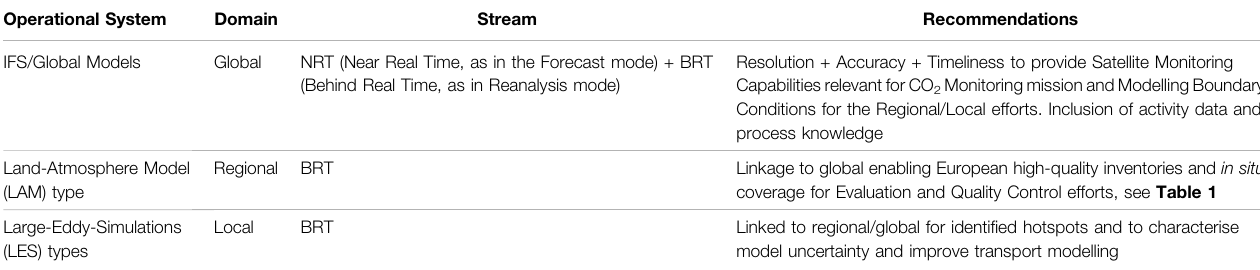
TABLE 2 | Proposed CHE prototype con fi gurations for global, regional and local domains. Operational